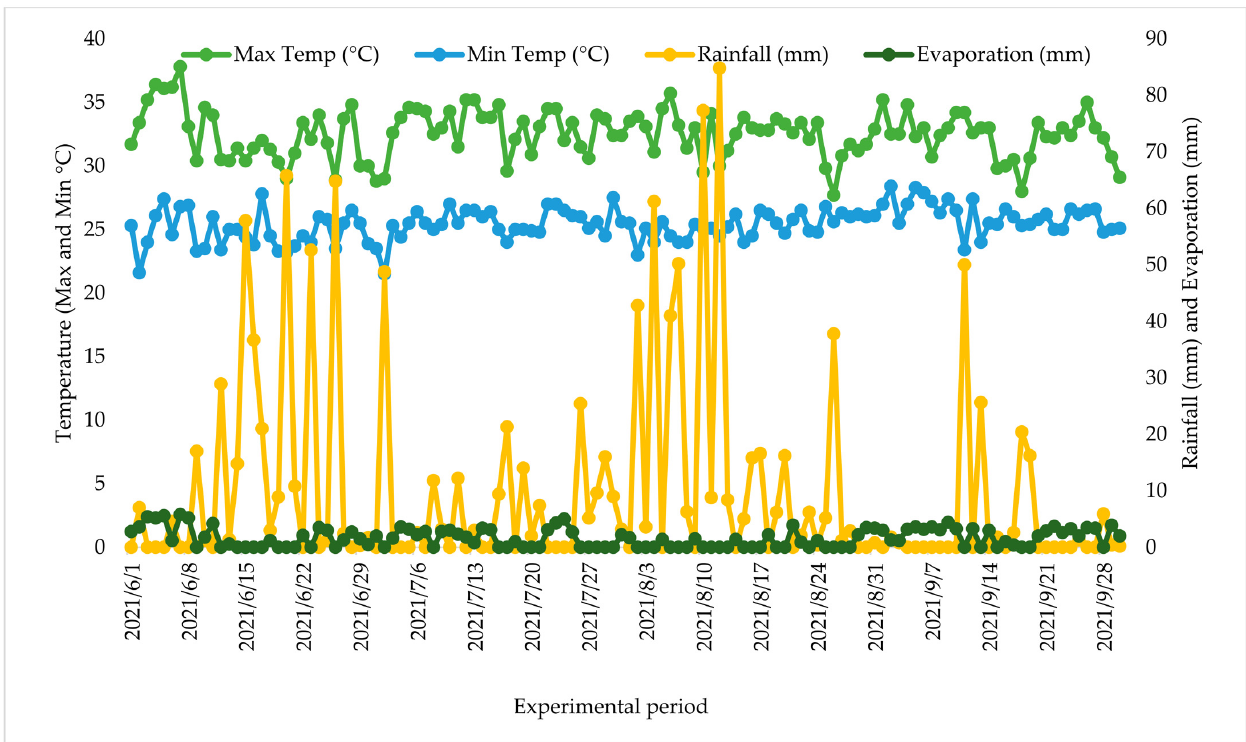
Figure 3. Climatic conditions during the kharif season of 2021: maximum and minimum temperatures, rainfall, and